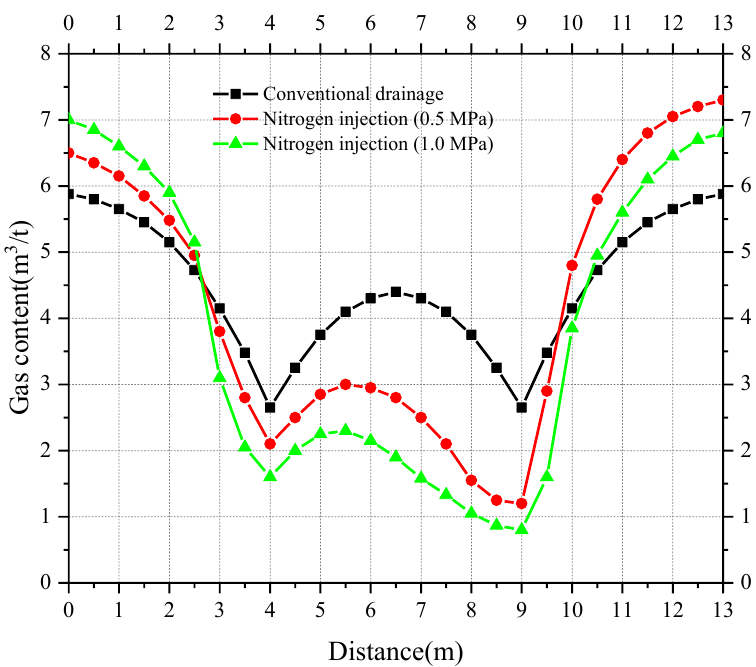
Figure 6. CH 4 content on the axis of boreholes .